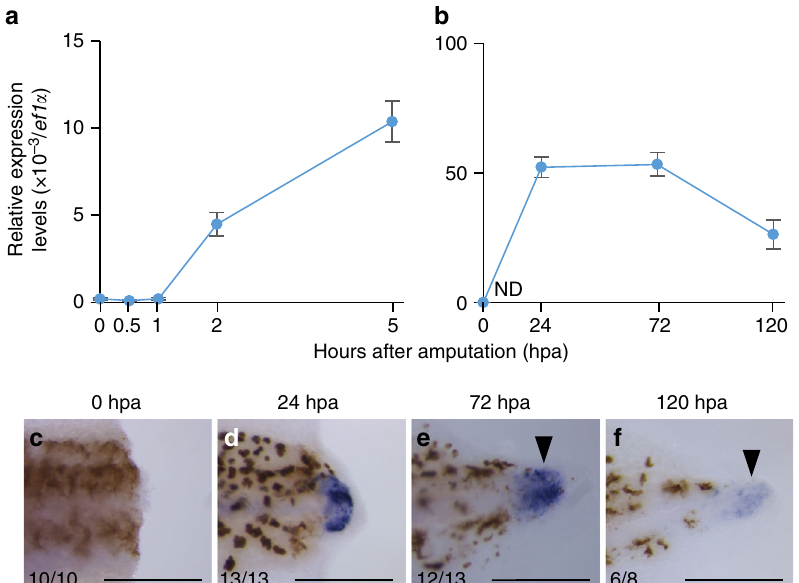
Fig. 1 il-11 is expressed at the tip of blastema during tail regeneration. a , b Expression levels of il-11 were measured by qRT-PCR using RNA extracted from ~20 tadpoles. Tail stump tissues cut at the level of 0.5 mm anterior from the amputated plane were used. Vertical axes represent relative expression levels of il-11 normalised by those of ef1 α . Mean ± s.e.m. n = 4. ND: not detected. c – f WISH was performed using tadpoles fi xed at 0 c , 24 d , 72 e , or 120 hpa f . Anterior is to the left and dorsal is up . Blue / purple colour represents signals for il-11 expression. Brown pigments are melanophores of the tadpoles. Scale bars : 500 μ m. Numbers at the bottom corner indicate the total ratio of tadpoles showing the corresponding expression pattern from at least two batches. Note that il-11 was expressed at the blastema tip at 72 and 120 hpa ( black arrowheads